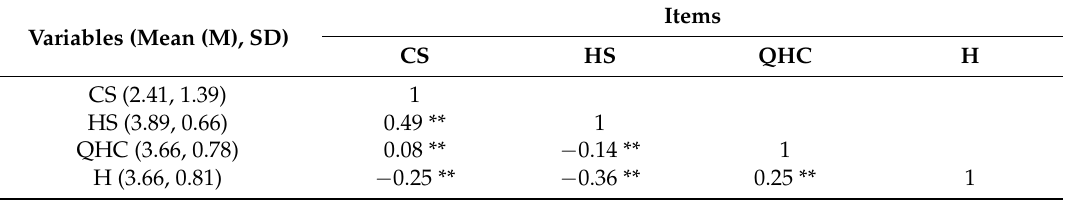
Table 3. Intercorrelations between Challenge Stress (CS), Hindrance Stress (HS), Quality of health care (QHC), and Health (H) items (** p <